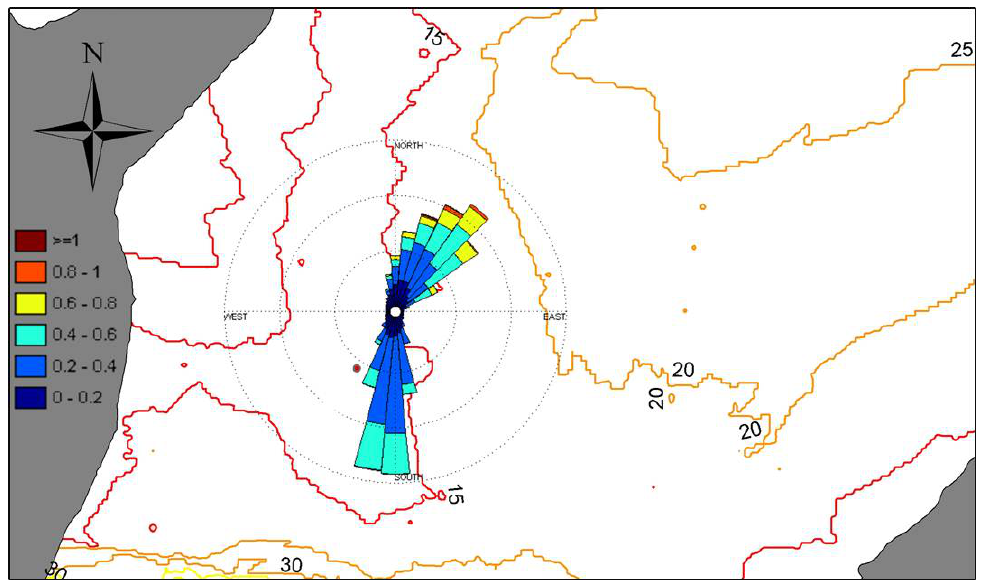
Figure 5. Direction and velocity for the ADCP measurement series. Lengths of bars show incidence of each direction segment and the color bar shows the velocity in m/s.